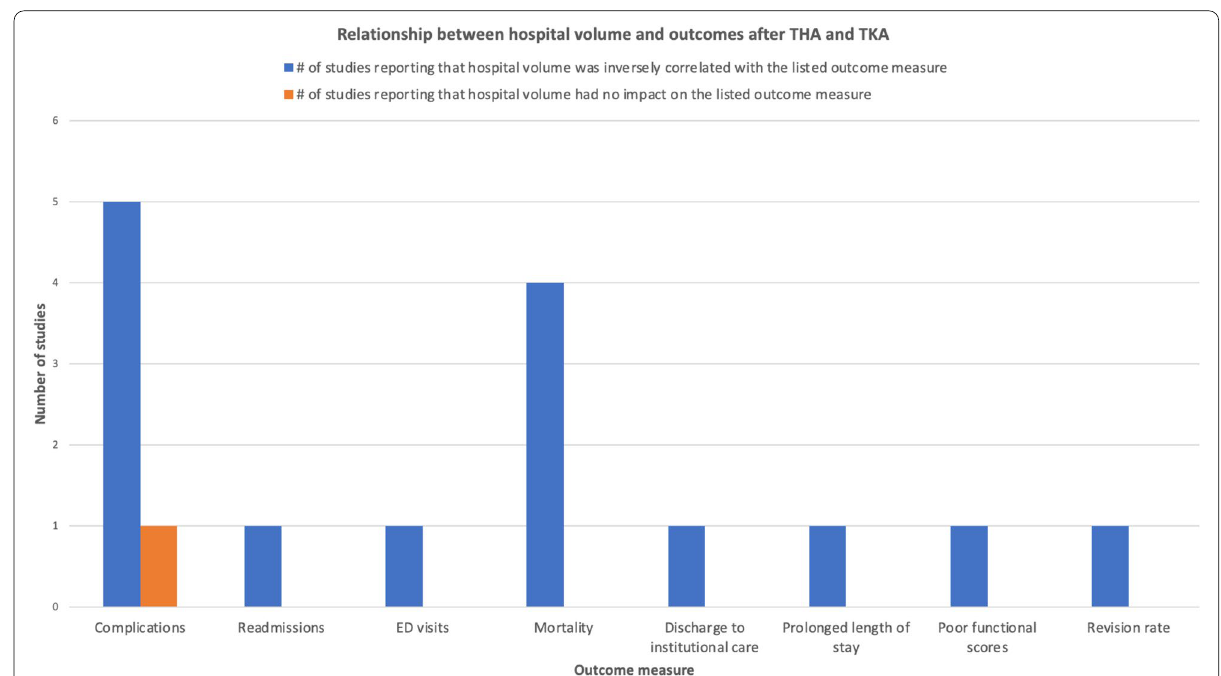
Fig. 5 Hospital volume is inversely correlated with complication rate, readmissions, mortality, and other negative outcomes after